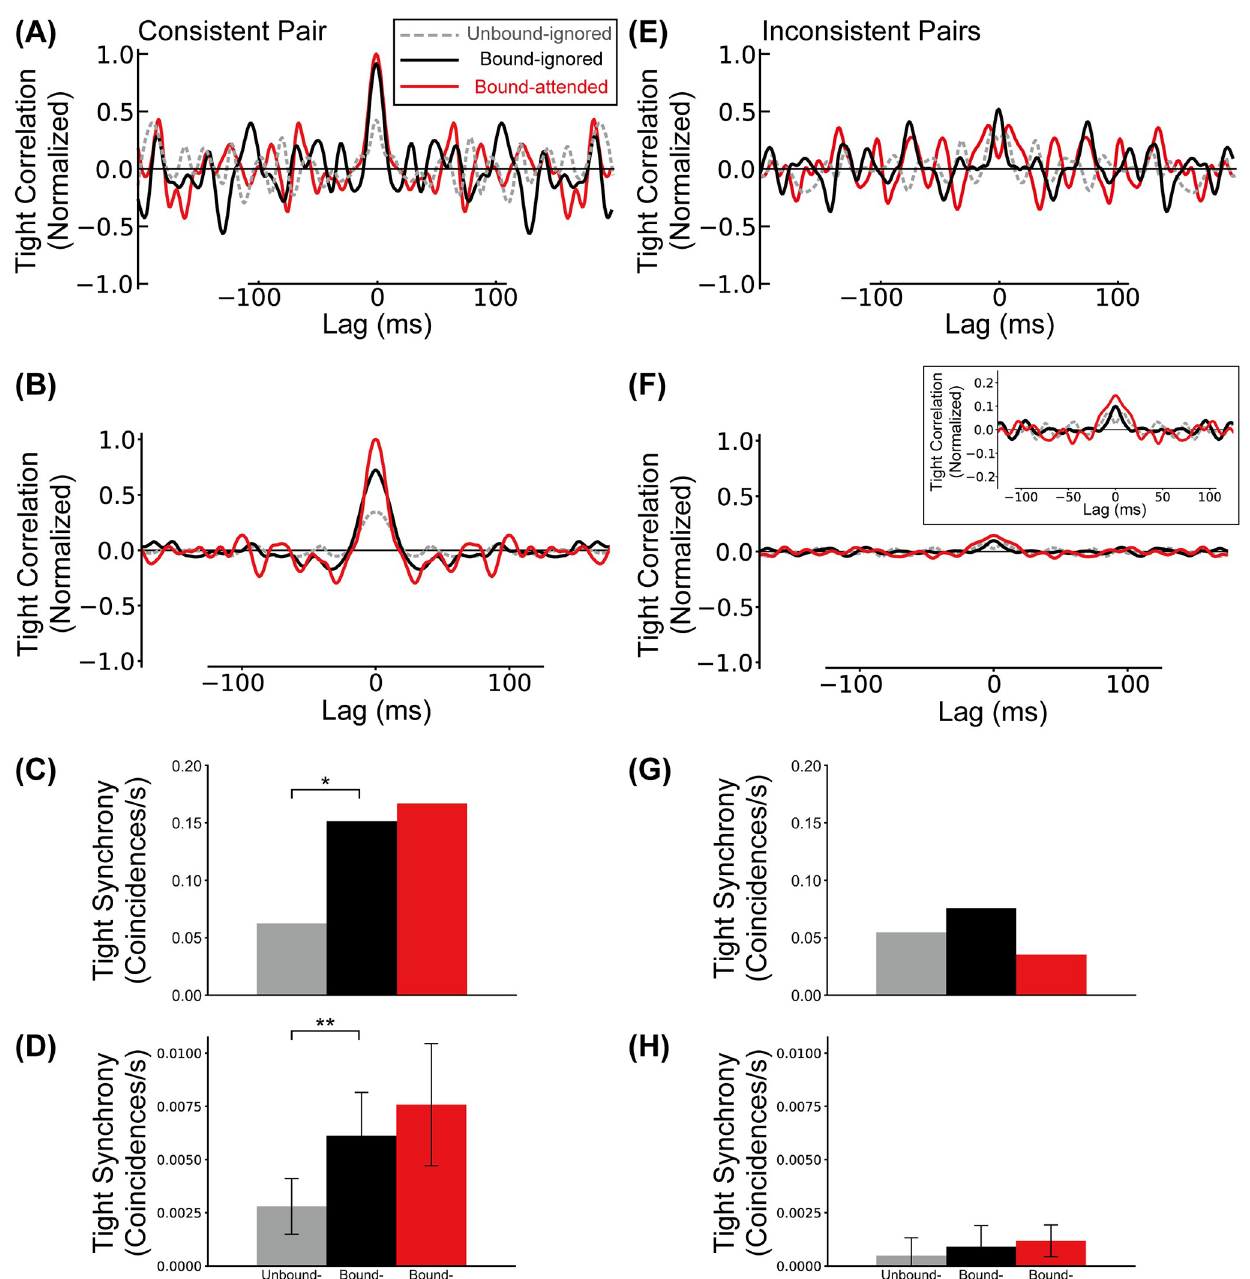
Fig 5. Tight synchrony between model BOS neurons. Reduced cross-correlations after subtraction of Δ = 20 ms interval jitter cross-correlation. A, C: Experimentally observed mean tight correlation and tight synchrony of the consistent pair for the Unbound-ignored (gray), Bound-ignored (black), and Bound-attended (red) conditions from [39]. B, D: Simulated tight correlation and tight synchrony of the consistent pair. Conventions are the same as those in A and C. Confidence intervals of tight synchrony of this pair for the Unbound-ignored, Bound-ignored, and Bound-attended conditions (panel D) were 0.0028 ± 0.0008 ( SD = 0.0013), 0.0061 ± 0.0013 ( SD = 0.0020), and 0.0076 ± 0.0018 ( SD = 0.0029) coincidences / s , respectively. E, G: Experimentally observed mean tight correlation and tight synchrony of the inconsistent pair. F, H: Simulated tight correlation and tight synchrony of the inconsistent pairs. Inset in the panel F shows central area at higher scale. Confidence intervals of tight synchrony of these pairs for the Unbound-ignored, Bound-ignored, and Bound- attended conditions (panel H) were 0.0005 ± 0.0005 ( SD = 0.0008), 0.0009 ± 0.0006 ( SD = 0.0010), and 0.0012 ± 0.0005 ( SD = 0.0007) coincidences / s , respectively. Curves in all panels are normalized by the maximum value of the “Bound-attended” condition of the consistent pair. The observed maximal values were: A:17.4, B:3.7, C:3.4, D:0.5 coincidences / s 2 . Asterisks indicate significant differences between conditions ( � p < 0.05, �� p < 0.01, t-test). Error bars indicate